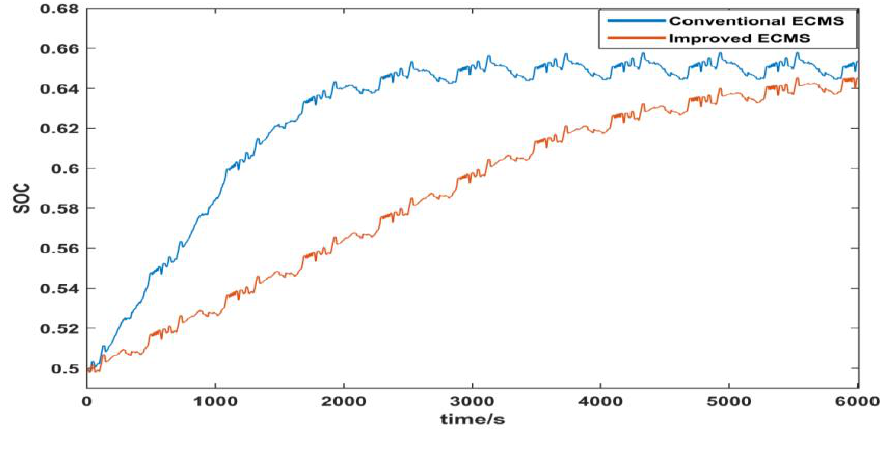
Figure 10. US06 condition.